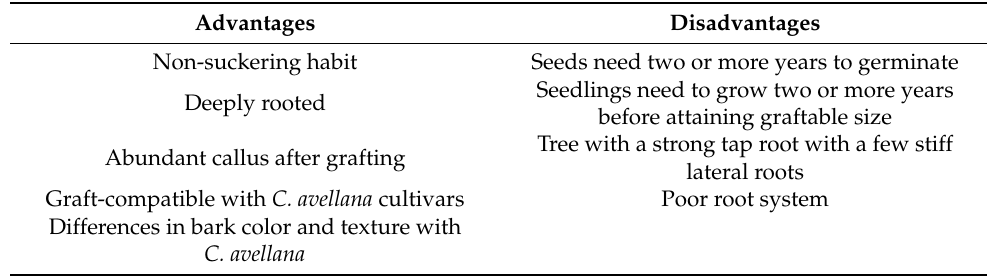
Table 1. Advantages and disadvantages of Corylus colurna L. seedlings as a rootstock